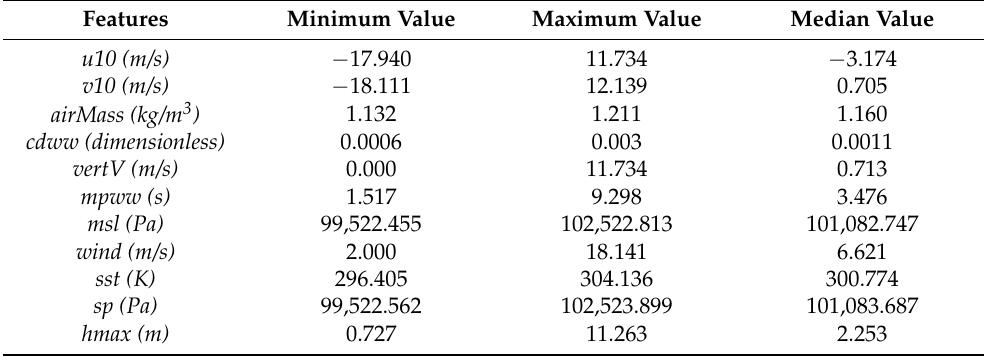
Table 2. The statistics of individual